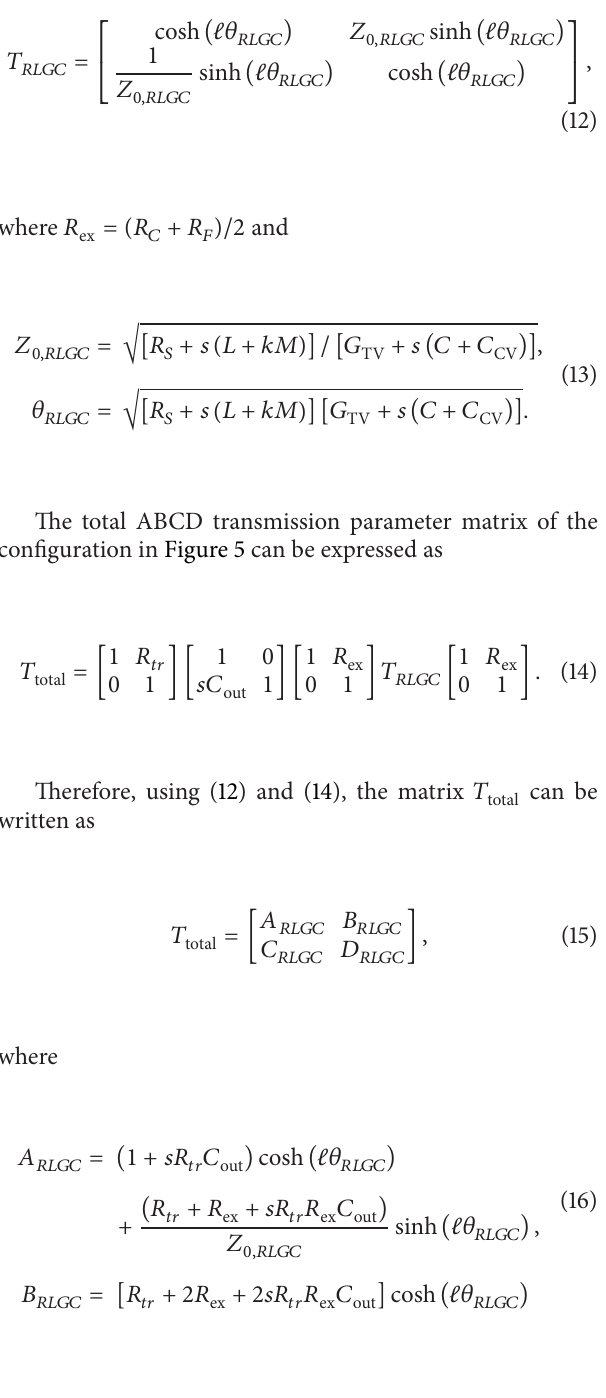
Figure 4: Input voltages of the aggressor and victim lines.